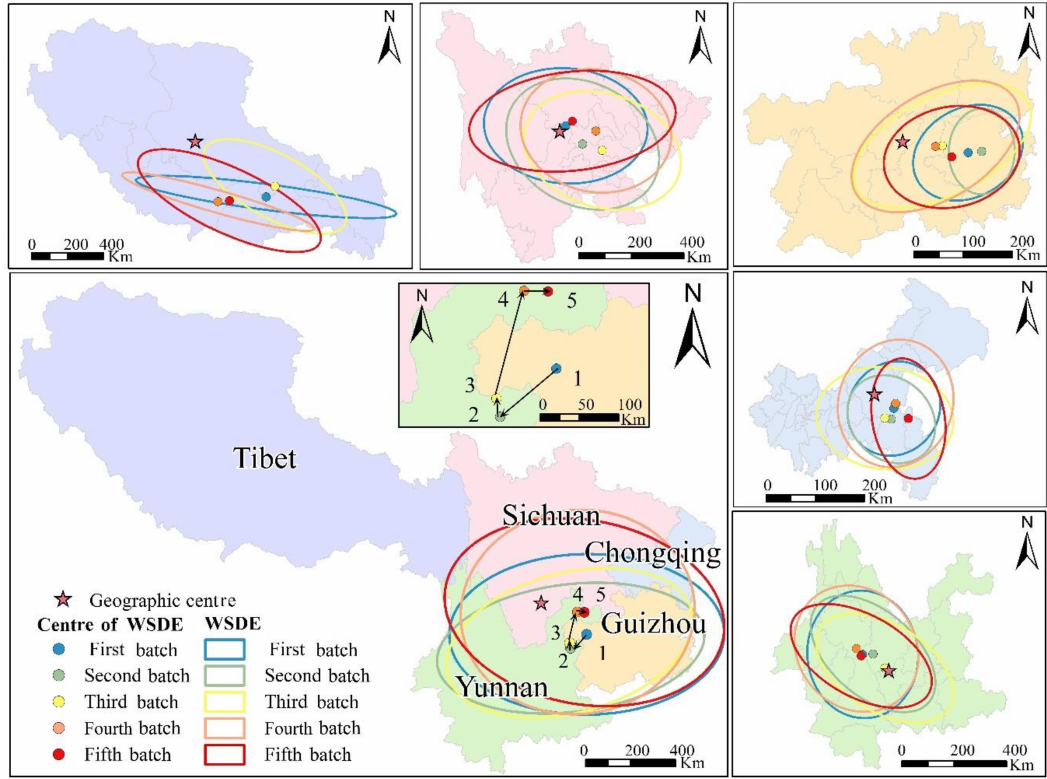
Figure 10. The WSDEs and the trajectories of centers for southwestern China and subordinate